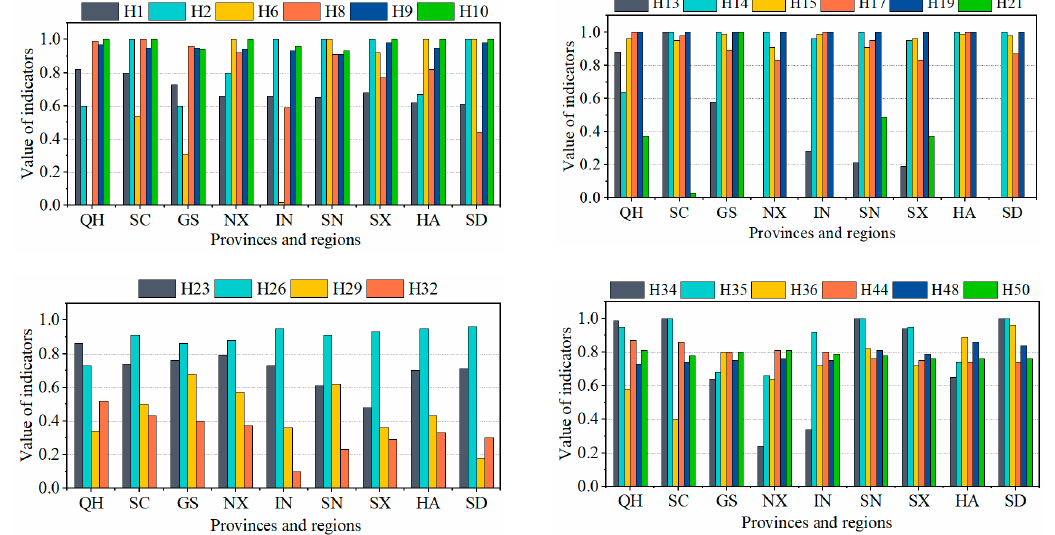
Figure 6. Membership degree values of happy river indicators for different provinces and regions along the Yellow River mainstem. Here, the labels “QH”, “SC”, “GS”, “NX”, “IM”, “SN”, “SX”, “HA”, and “SD” refer to the provinces and regions of Qinghai, Sichuan, Gansu, Ningxia, Inner Mongolia, Shaanxi, Shanxi, Henan, and Shandong, respectively.